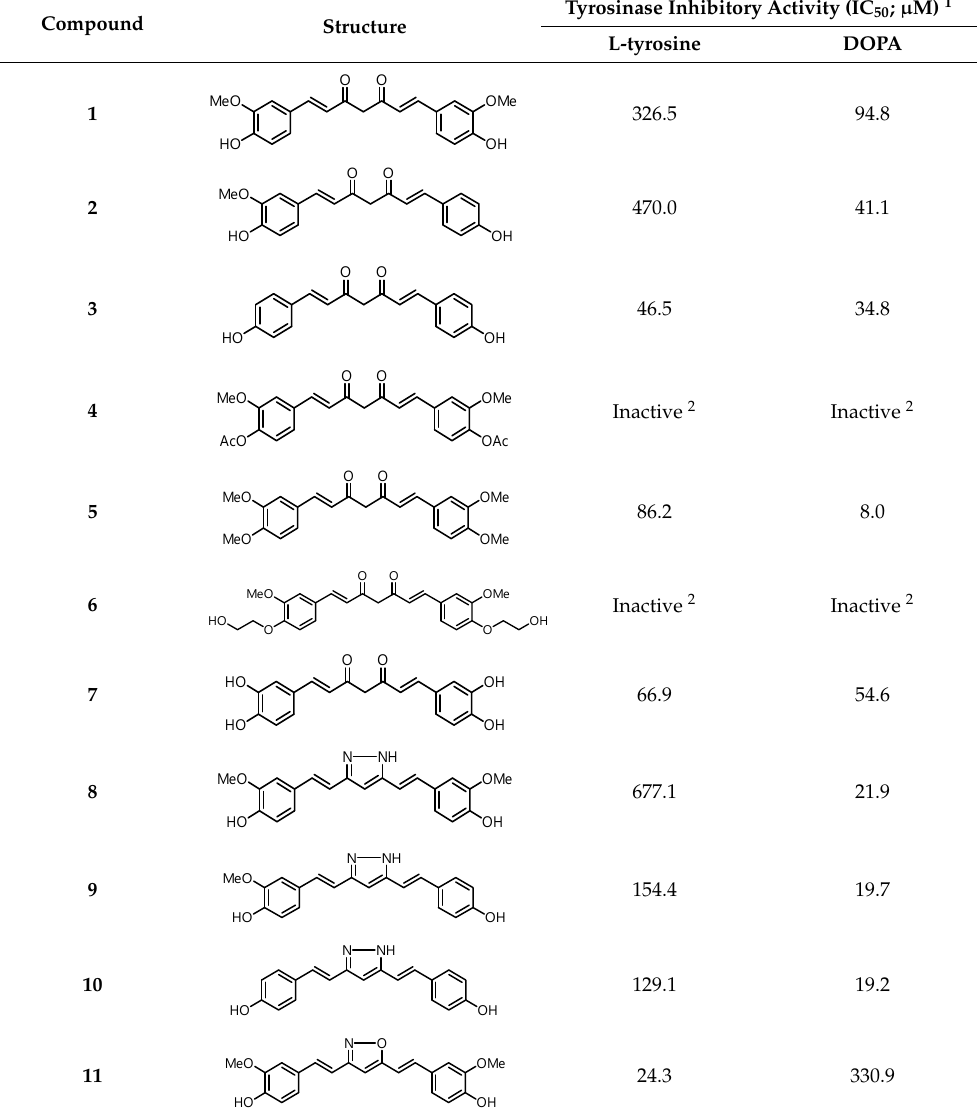
Figure 1. Structure − activity relationship (SAR) analysis of curcuminoids and their analogues. Table 1. Tyrosinase inhibitory activity of natural curcuminoids ( 1 – 3 ) and synthetic analogues ( 4 – 17 ) on L-tyrosine and DOPA substrates.